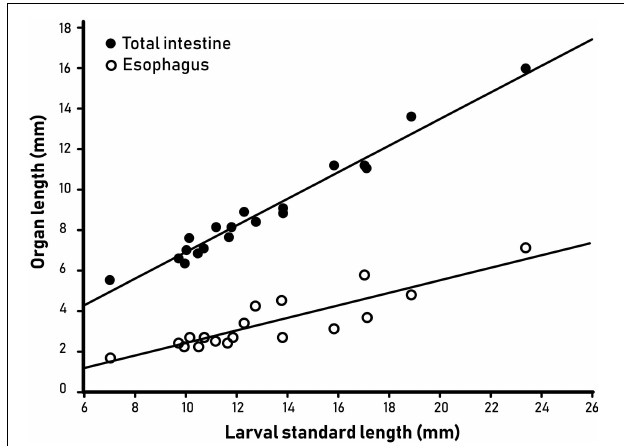
FIGURE 3 | Length of the total intestine and esophagus of leptocephalus larvae of the European eel ( Anguilla anguilla ) plotted versus larval standard length.